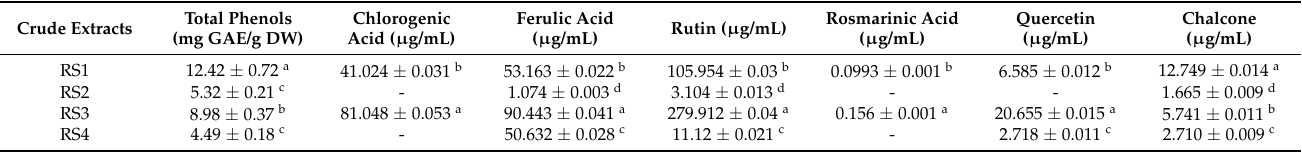
Table 1. Total phenolic contents and HPLC identification and quantification of components of the crude extracts of the leaves of Raphanus sativus L.